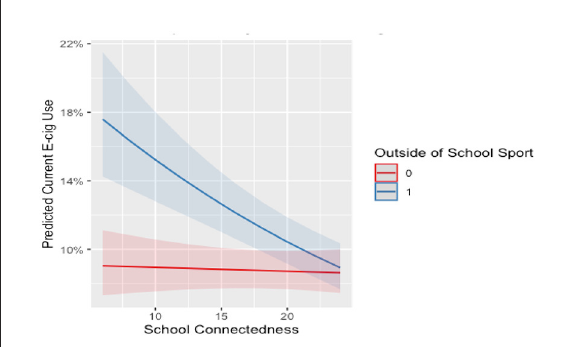
FIGURE3 Interaction between school connectedness and MVPA level E-cigarette use for males. E-cig, E-cigarette; 0, not participating; 1, participating; PA level, meeting the MVPA guidelines. Line and shade, mean and SE.